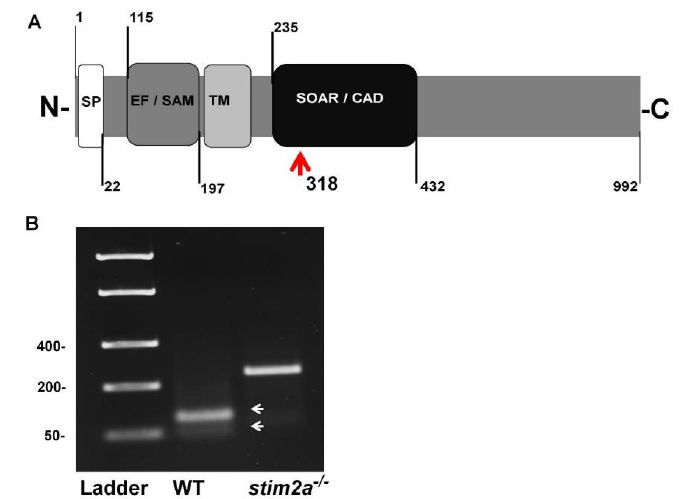
Figure 1. Generation of stim2a −/− mutant line. ( A ) Schematic illustration of Stim2a protein domains. SP, signal peptide; EF/SAM, EF-hand/sterile α-motif (EF/SAM) Ca 2+ -binding endoplasmic reticulum (ER)-luminal domain; TM, transmembrane domain; SOAR/CAD, STIM1 Orai1-activating region/CRAC-activating domain. Numbers indicate amino acid positions. The red arrow indicates the site of the stop codon introduction. ( B ) Representative gel electrophoresis of the restriction length fragment polymorphism (RLFP) analysis of genotypes (white arrows indicate wildtype (WT) fragments after the cutting) of the PCR product. The mutant is not cleaved.